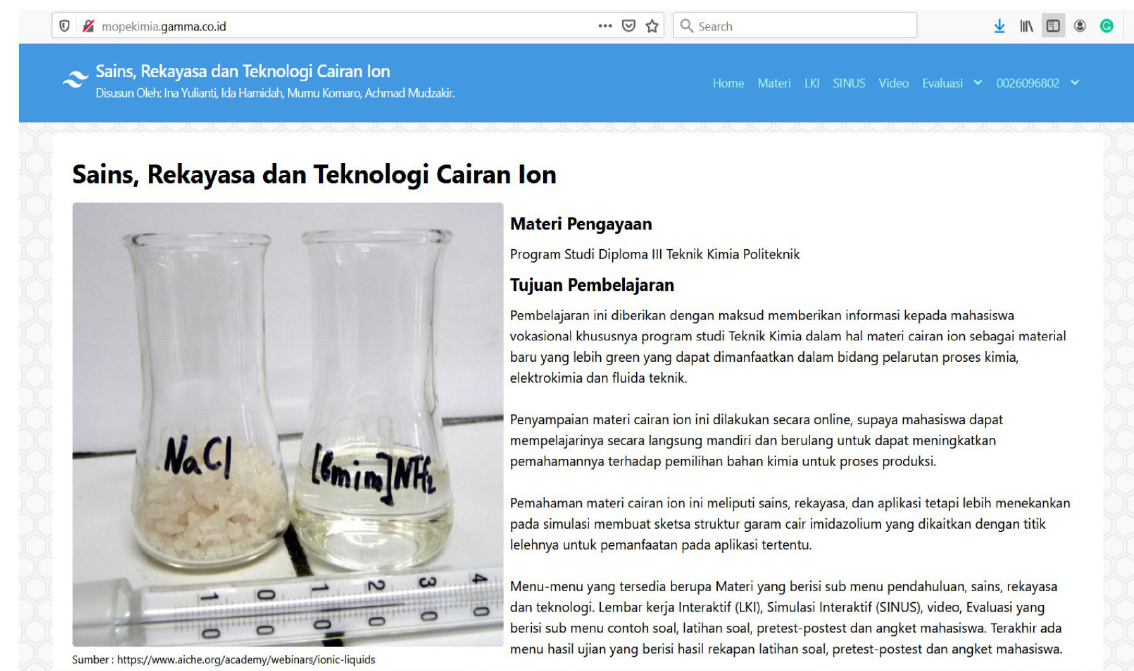
Figure 1. Web-based ionic liquids learning design (http://mopekimia.gamma.co.id)